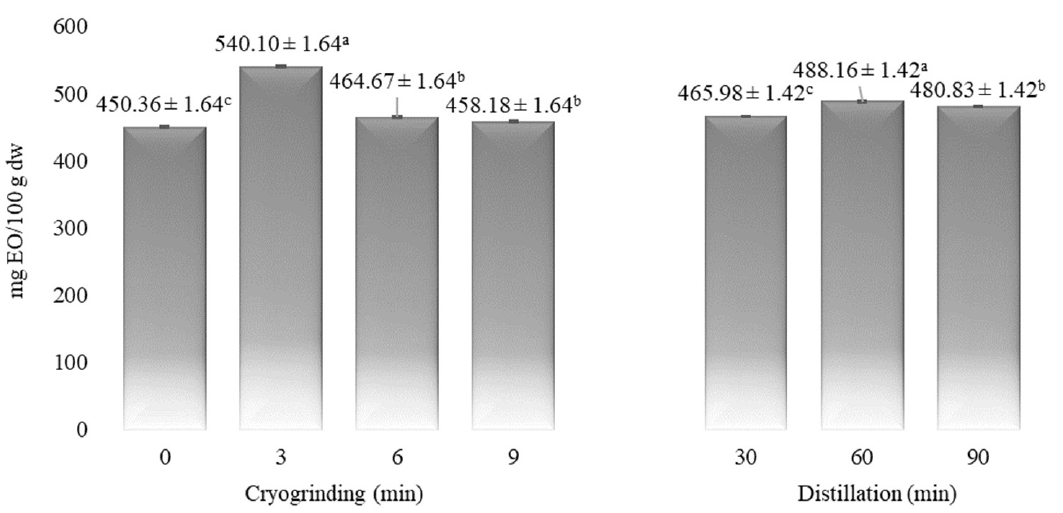
Figure 1. Influence of CG and distillation time on the yield of total EO. Results are expressed as mean (n = 8 for cryogrinding time and n = 6 for extraction time) ± SE. Different letters indicate significant differences between the means ( p ≤ 0.05).